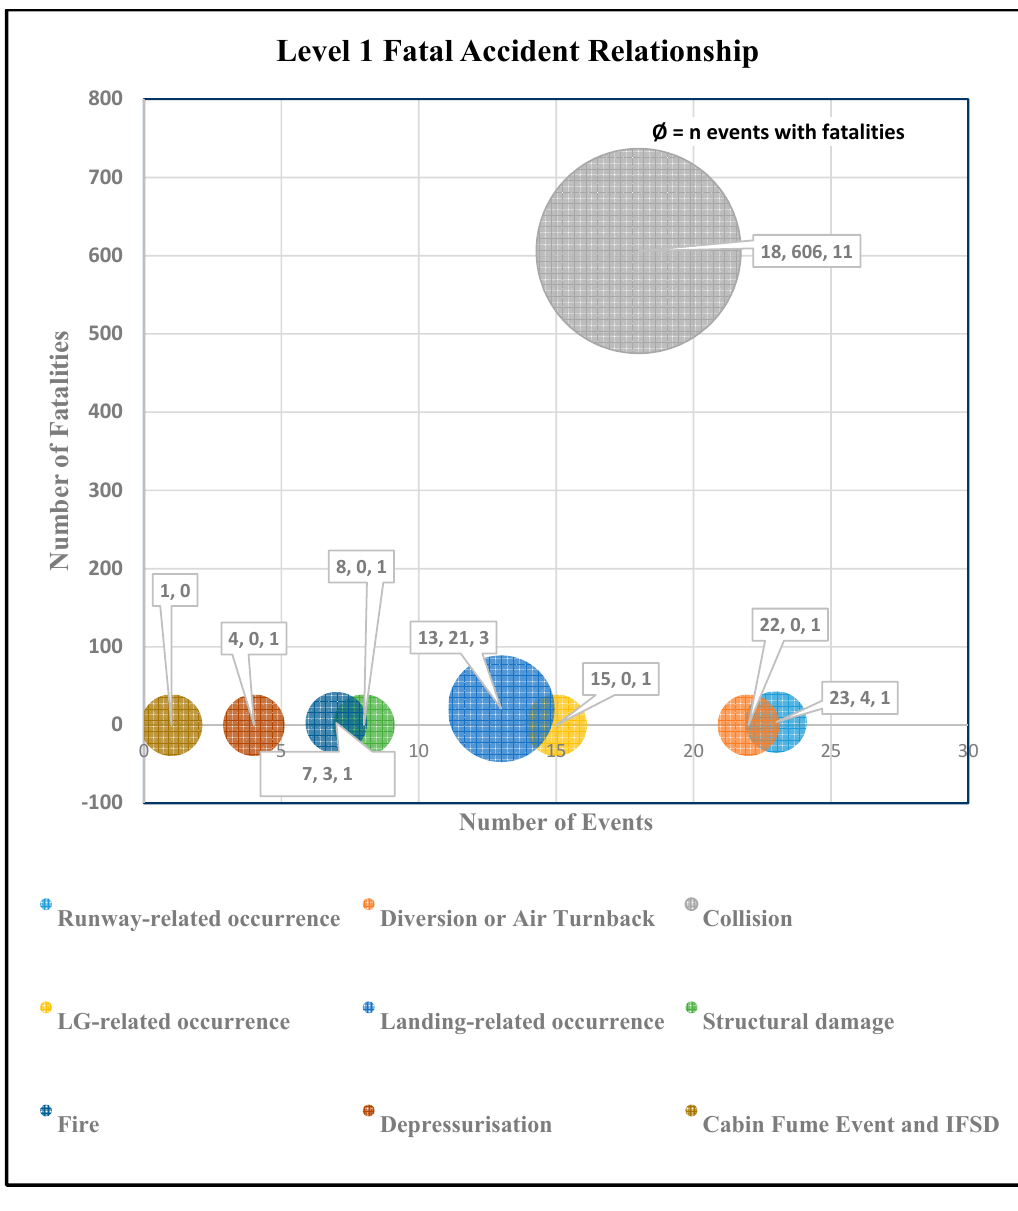
Figure 10. Level 1 fatal accident relationship.